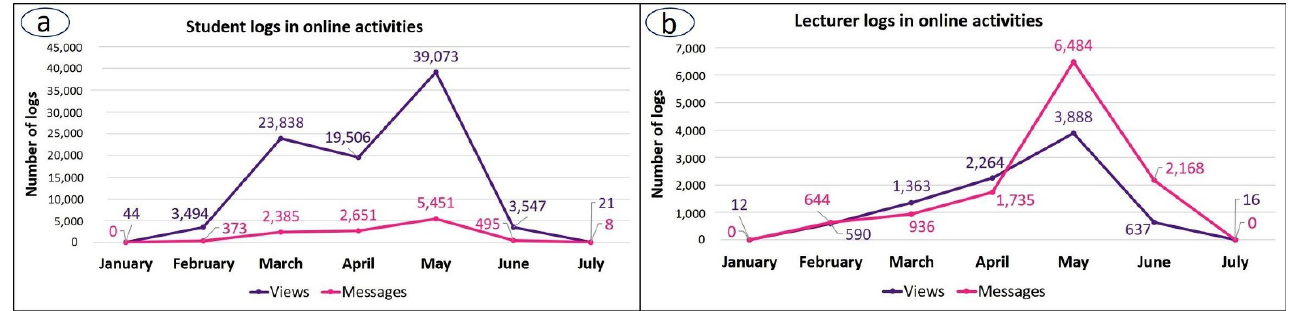
Figure 1. Total student and lecturer Moodle logins for the cytology and histology subject courses recorded throughout the lockdown-adapted course. Schedule of main activities: (a) Start date of cytology and histology teaching (10 February); (b) Start date of COVID-19 lockdown, which coincided with the start of microscopic anatomy teaching (14 March and 17 March, respectively); (c) Date of first term exam (28 April); (d) Date of second term and final exams (25 May); (e) Exams for students who failed the subject (18 June).